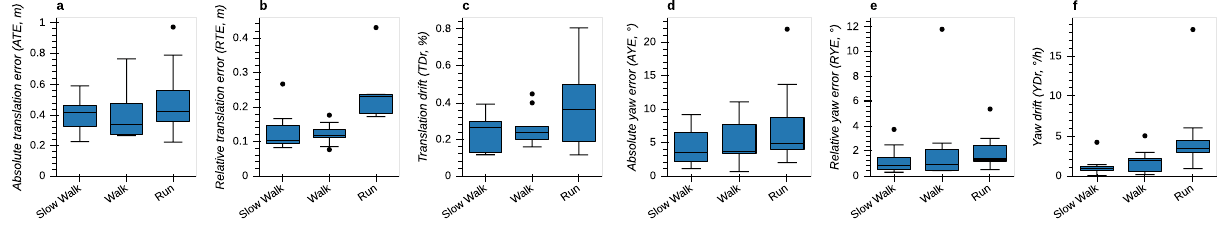
Figure 5. Boxplots of translation and yaw errors between T265 and OTS across different tasks. ( a ) Absolute translation error. ( b ) Relative translation error. ( c ) Translation drift. ( d ) Absolute yaw error. ( e ) Relative yaw error. ( f ) Yaw drift.